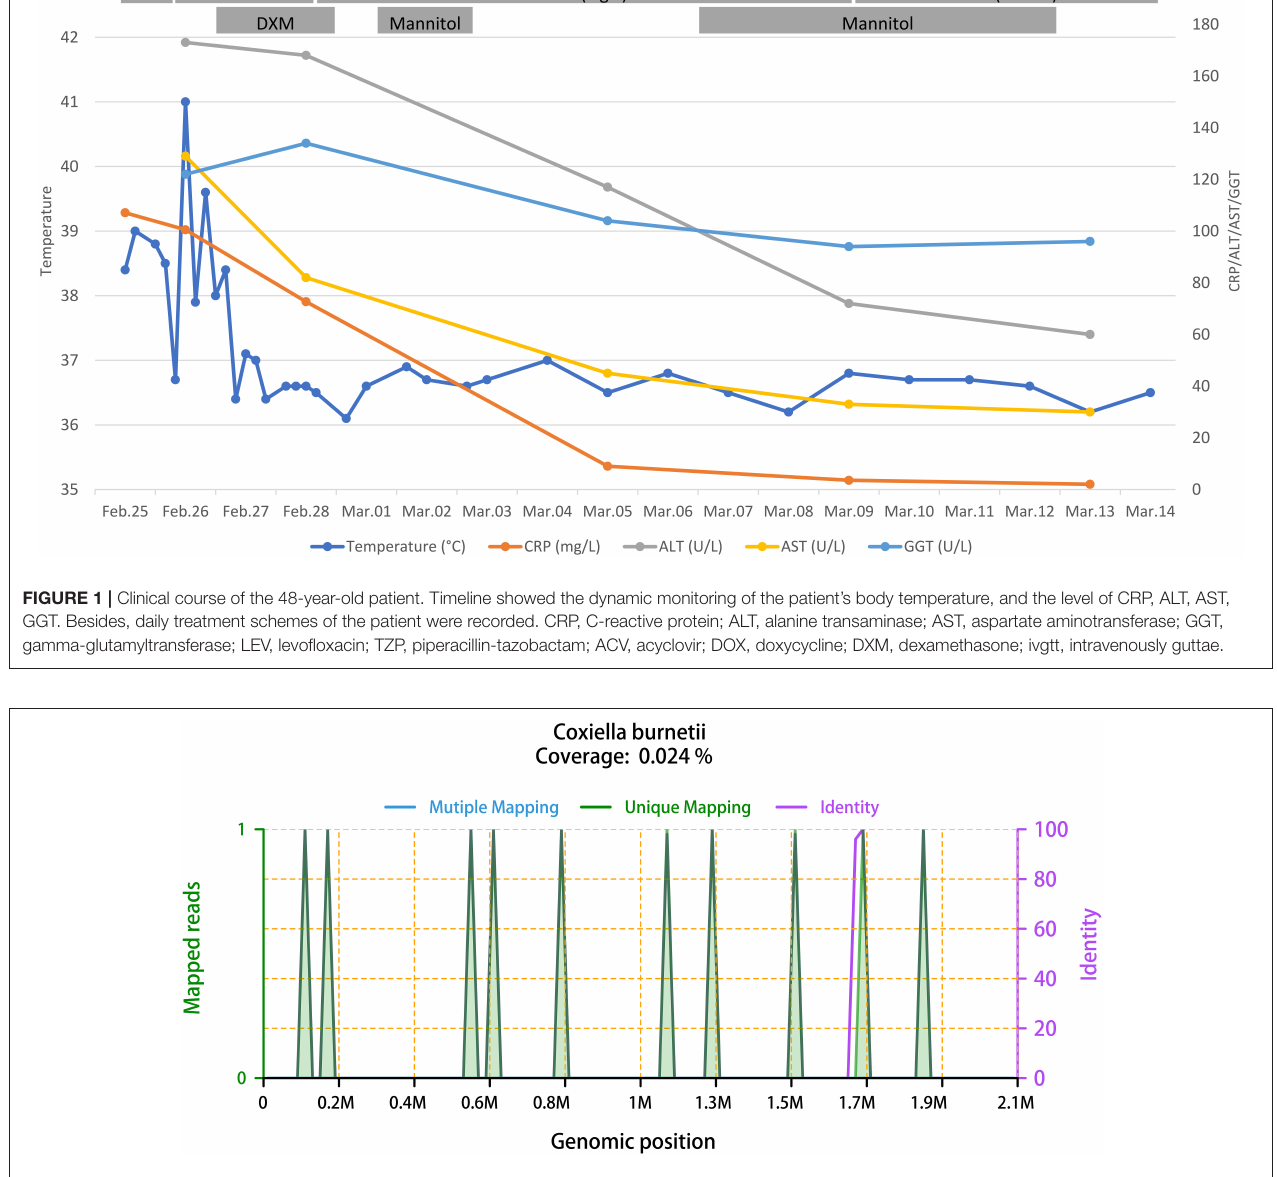
FIGURE 2 | The mapped reads of C. burnetii , with the genome coverage of 0.024%. It showed the distribution of ten “Unique mapping” reads of C. burnetii identified by mNGS in the overall genome of C. burnetii . The ten reads covered 0.024% of C. burnetii genome. “Mutiple Mapping” indicates that the read can be mapped with the genome of C. burnetii , but not unique. “Unique Mapping” means that the read can be uniquely mapped to the genome of C. burnetii , but cannot be mapped to other species. Each read of “Unique Mapping” has its corresponding “Identity”. One purple line that represents “Identity” is at around 1.7M genomic position. Another nine of the ten “Identity” curves are 100% overlapping with the green “Unique Mapping” curves, thus, they are not visible in this figure.